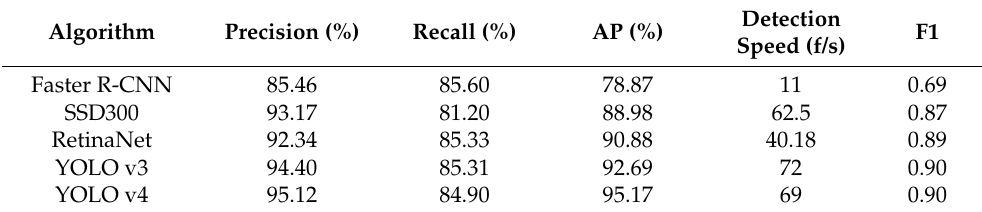
Table 5. Statistical results of different algorithms.